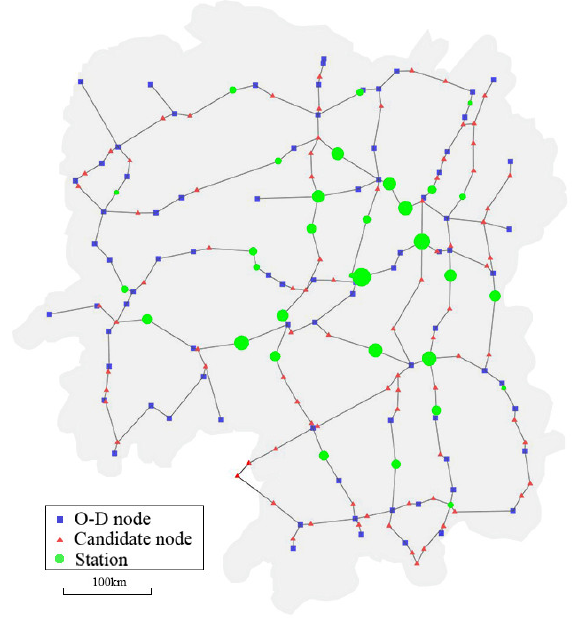
Figure 8. The optimal location and size of charging stations.